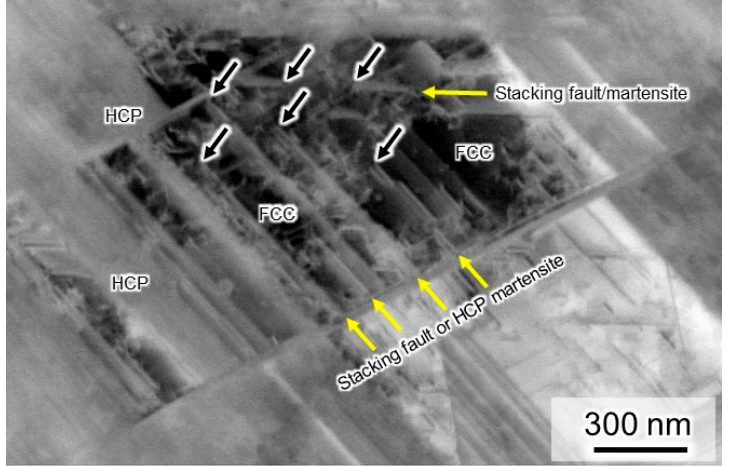
Figure 7. Further magnified ECCI image of the ausformed specimen. The black arrows indicate tips of the stacking faults or HCP martensite plates.